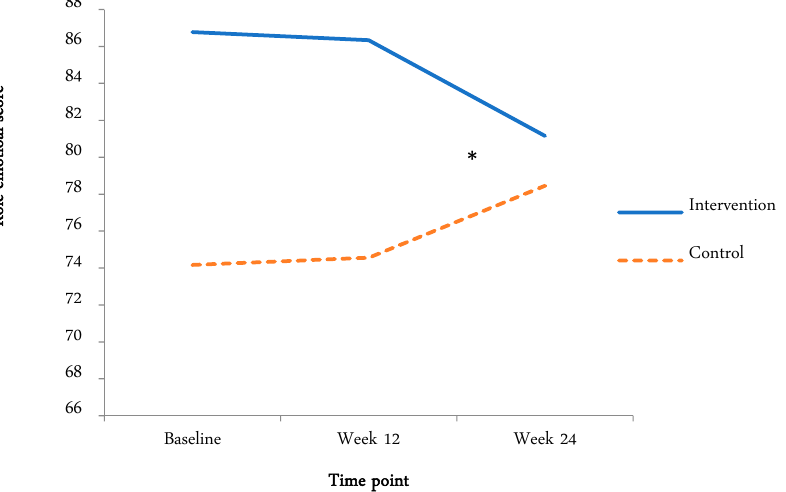
Figure 2. Fitness for intervention and control groups at baseline, week 12, and three-month follow-up. * Indicates significant time by condition interaction.